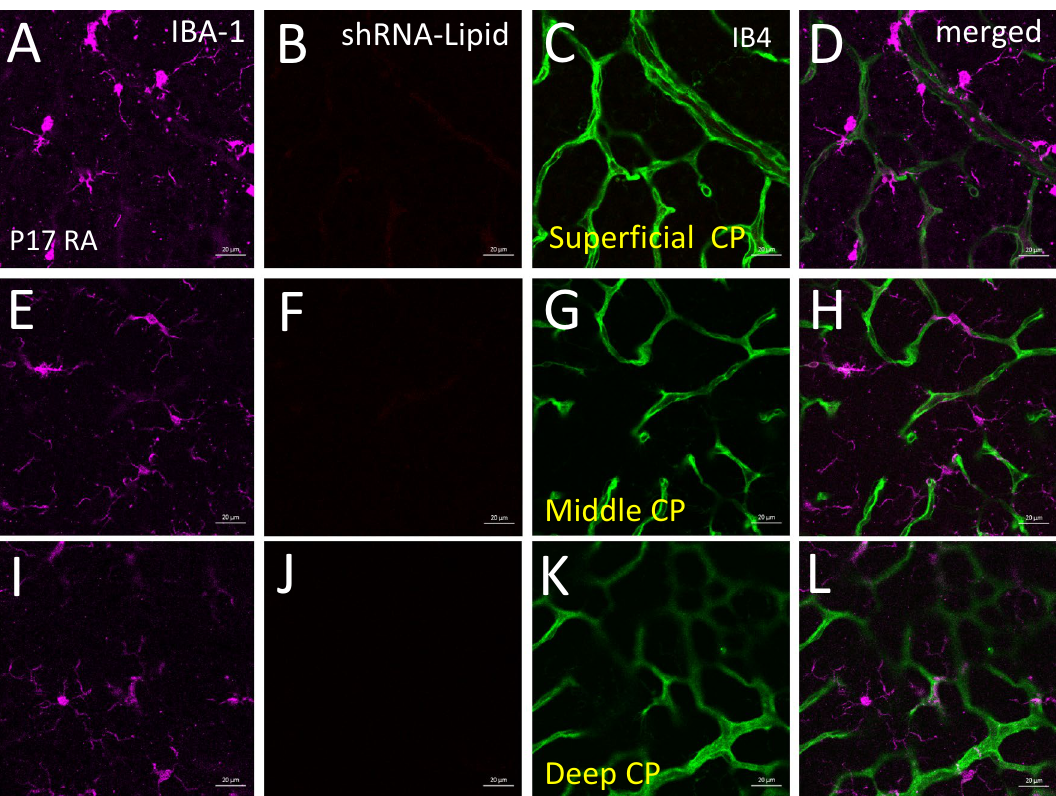
Figure 5. Ex vivo flat mounts of P17 mice maintained in normoxia and receiving intraperitoneal injections of AS-Eng-shRNA–lipid conjugates (normoxic controls). Flatmounts were immunostained with antibodies against IBA1 ( A , E , I ). IBA1 is a microglia/macrophage marker. Isolectin B4 was used to visualize the superficial capillary (SCP), middle capillary (MCP) and deep capillary (DCP) plexuses ( C , G , K ). Only minimal background AS-Eng shRNA–lipid-dependent fluorescence was observed, and not detected in SCP ( B ), MCP ( F ) and DCP ( J ). IBA1 positive cells were observed juxtapositioned to SCP ( A ), MCP ( E ) and DCP ( I ) and appeared to be ramnified. These data suggest IBA1 positive cells do not yield an AS-Eng-shRNA–lipid-dependent fluorescence in age-matched normal control mice and also suggest that the shRNA–lipids have no effect on retinal microglial activation. Scale bar 20